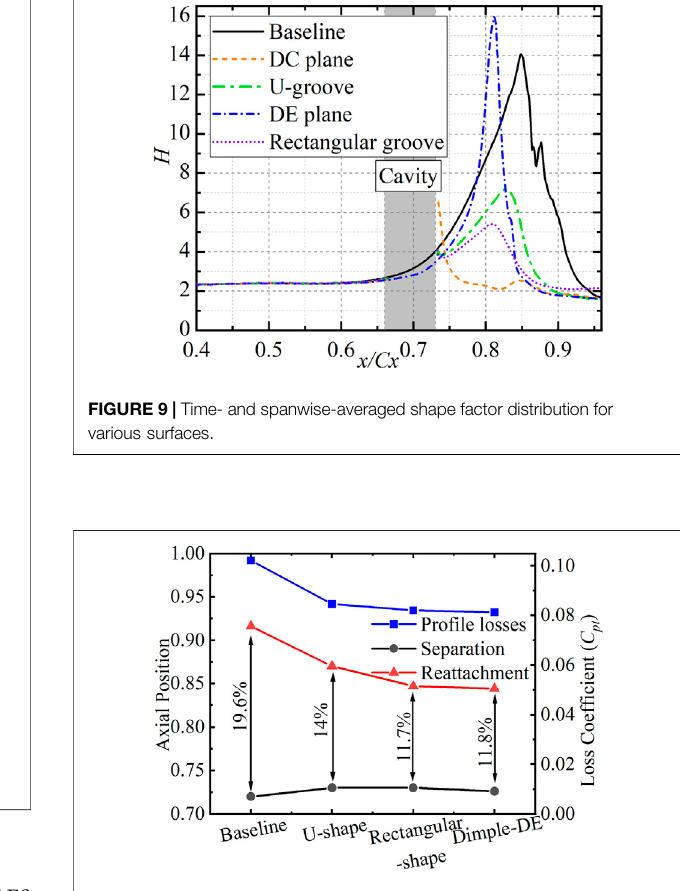
FIGURE 10 | Separation bubble length and the correlated pro fi le losses for various